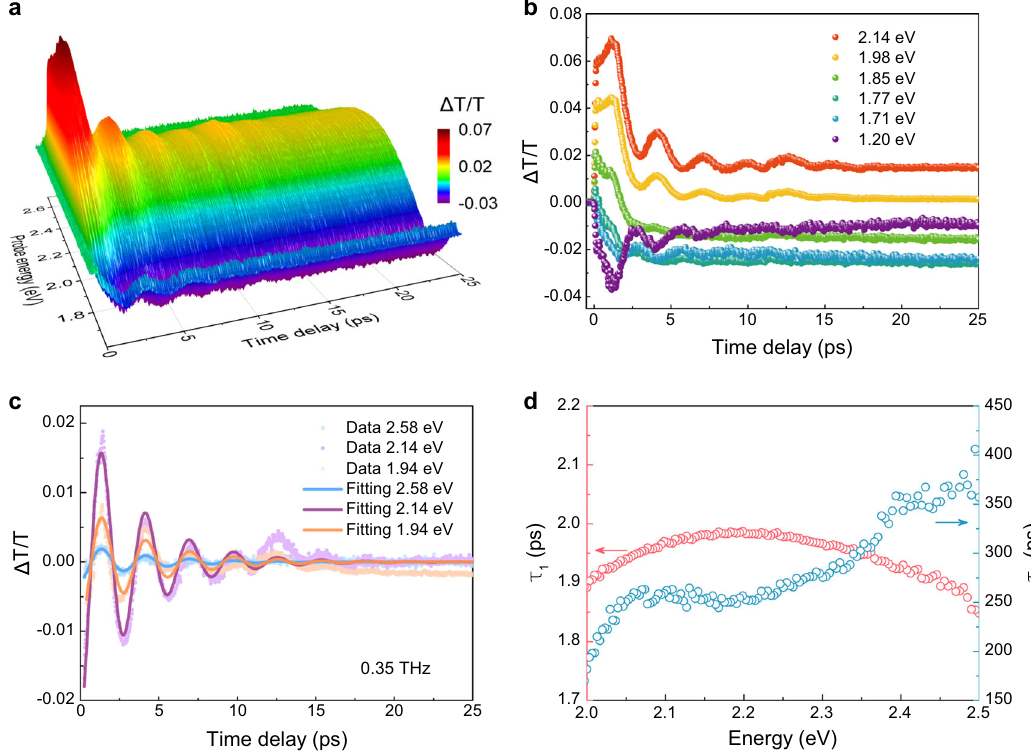
Fig. 4 Real-time observation of interlayer coherent vibrational dynamics of PdSe 2 . a 3D transient absorption spectrum in terms of differential transmission Δ T / T as a function of time delay and probe photon energy on a picosecond timescale. b Time-dependent Δ T / T with different probe photon energies. c Coherent phonon dynamics at 0.35 THz probed at photon energies of 2.58, 2.14, and 1.94 eV. The vibrational traces are fi tted using an exponentially damped sinusoid model. d Fast decay time τ 1 and exciton lifetime τ 2 as a function of probe photon energy. The best- fi t value is fi tted using a bi-exponential decay model with a criterion of the minimum standard deviation of the